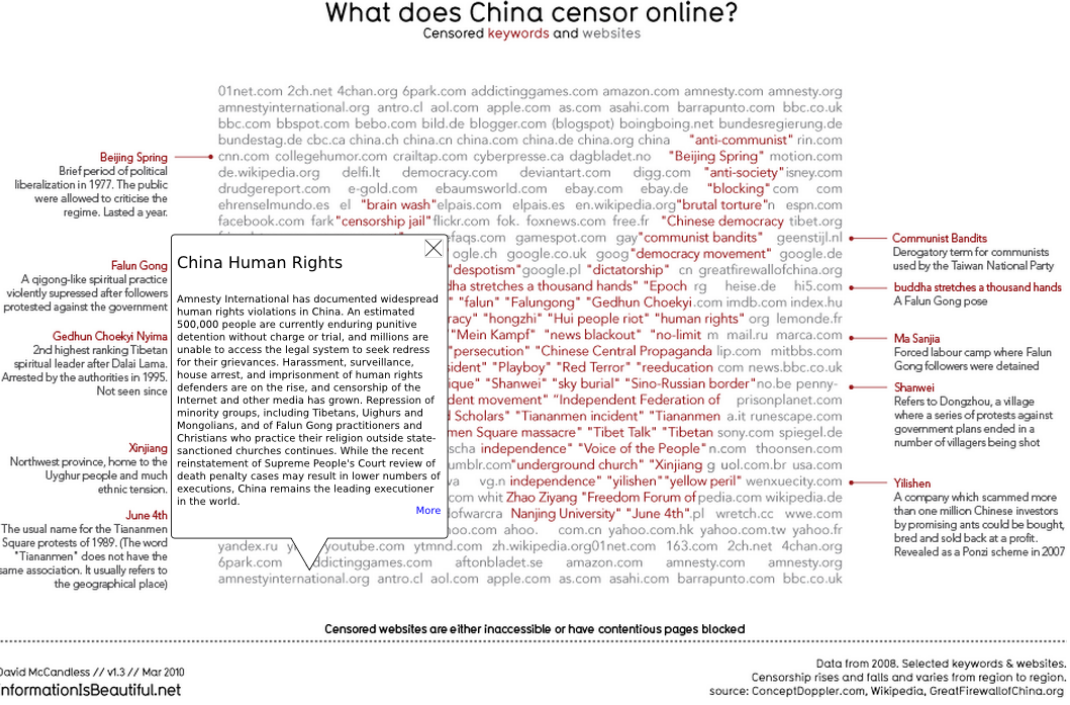
Figure 17. Figueiras shows a visualization of Chinese online censorship enhanced with storytelling. An interactive feature is added so that the user can click on an instance of censorship to learn more about it. This supplies context to the user and also may draw an empathetic response from the user [38]. Image courtesy of Figueiras